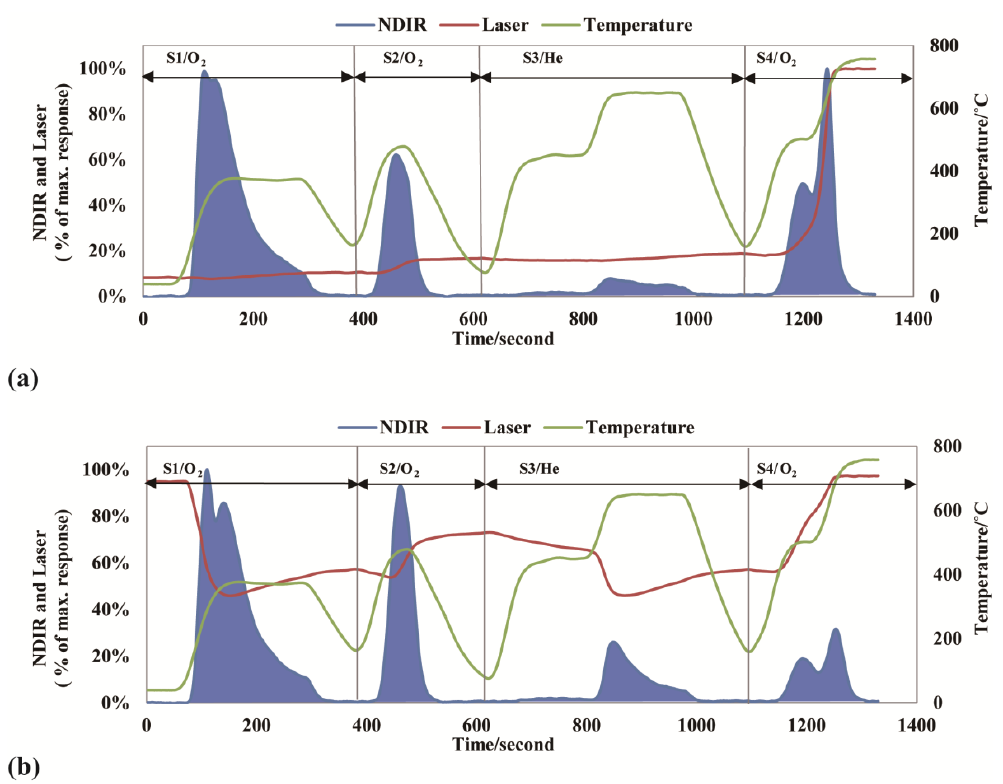
Fig. 4. Fig. 4. Thermograms of a water-extracted aerosol sample (SOL) (a) and its water extract after dropped on a blank filter (b) , using the Swiss 4S protocol (S2: 475 ◦ C, S3: 650 ◦